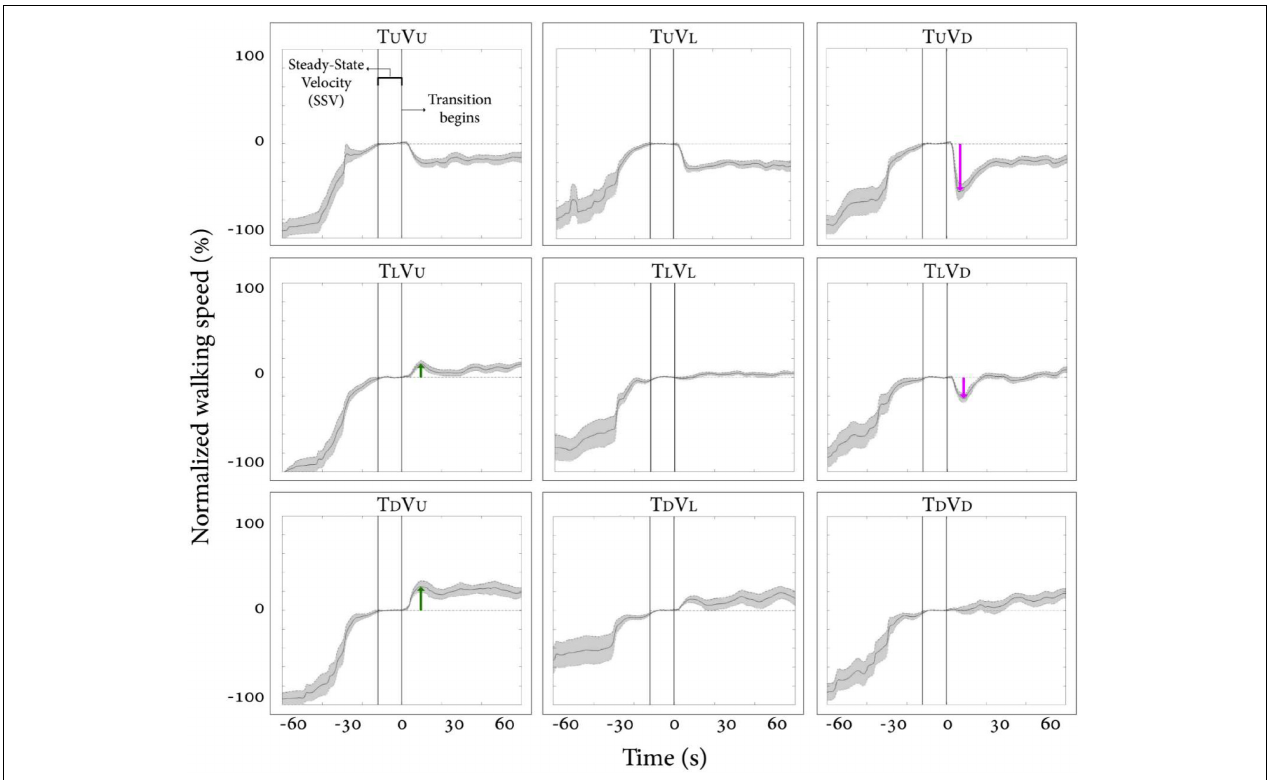
FIGURE 2 | Post-transition adaptation of gait speed. Average self-paced gait speed ( N = 12) relative to steady-state velocity (in %) for each condition. Time zero demarcates the end of the steady-state velocity period, after which a 5-s transition of the treadmill and/or visual scene occurred. Gray shading represents the standard error. Green arrows represent the peak of exertion effects in visual uphill walking, and red arrows represent the peak of braking effects in visual downhill walking. Irrespective of treadmill inclination upon transition, there is a tendency for a virtual (visual) downward transition to be followed by a decrease in gait speed and, to a lesser extent, for an upward visual transition to be followed by an increase in gait speed. Conditions: treadmill (T) and/or visual scenes (V) inclination transitioned to 10 ◦ uphill (U), remained leveled at 0 ◦ (L), or transitioned to − 10 ◦ downhill